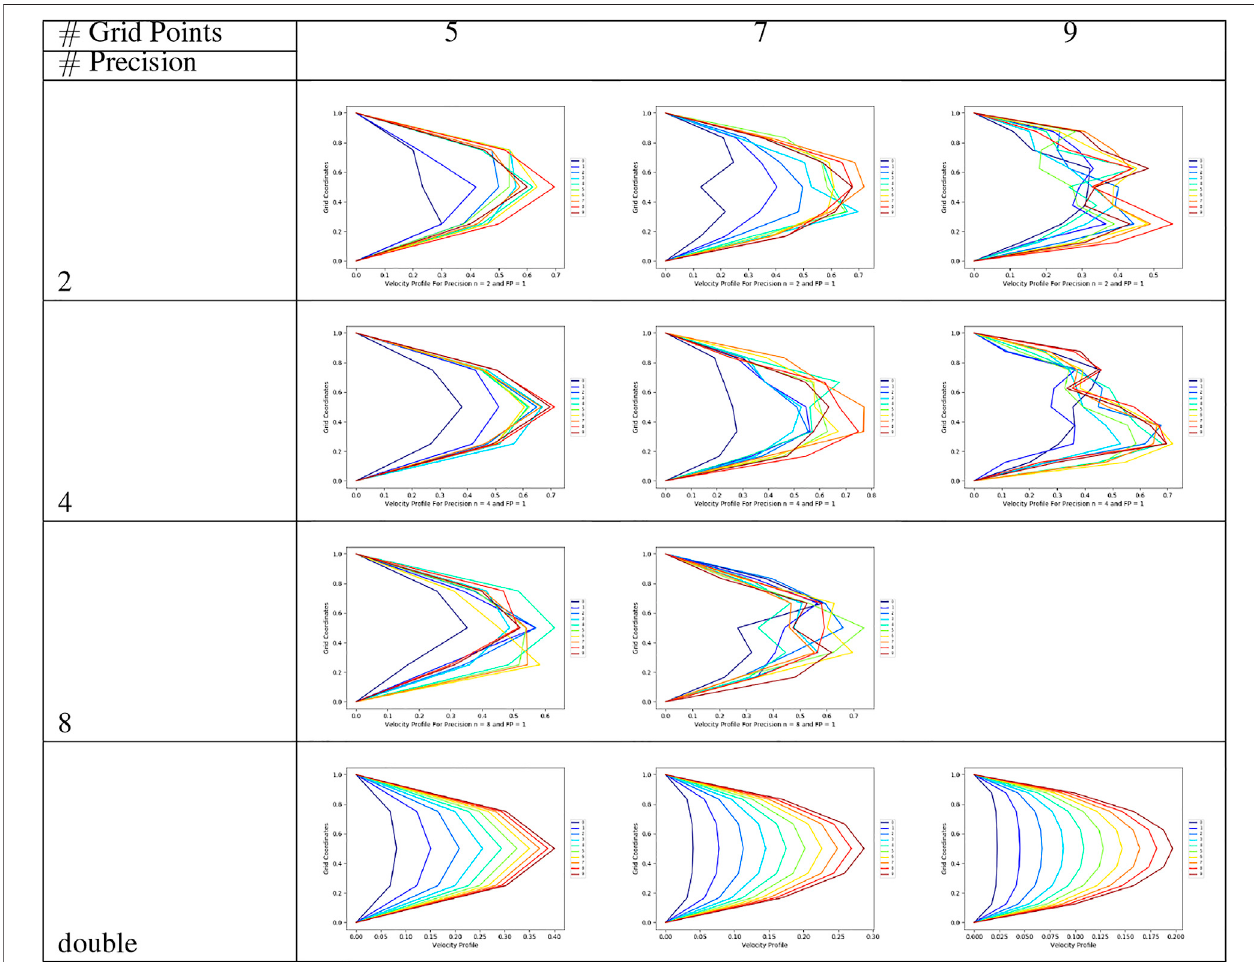
FIGURE 5 | Solution pro fi les corresponding to unweighted mean state for precision ’ s 2, 4, 8 and double for mesh with sizes 5, 7 and 9.